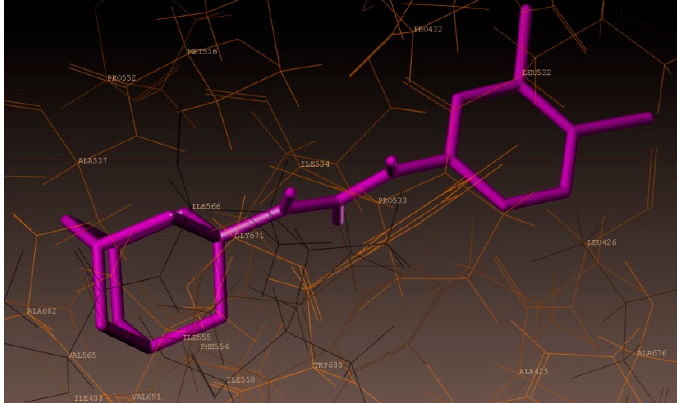
Figure 8. Hydrophobic amino acids surrounding compound 3l (magenta color).